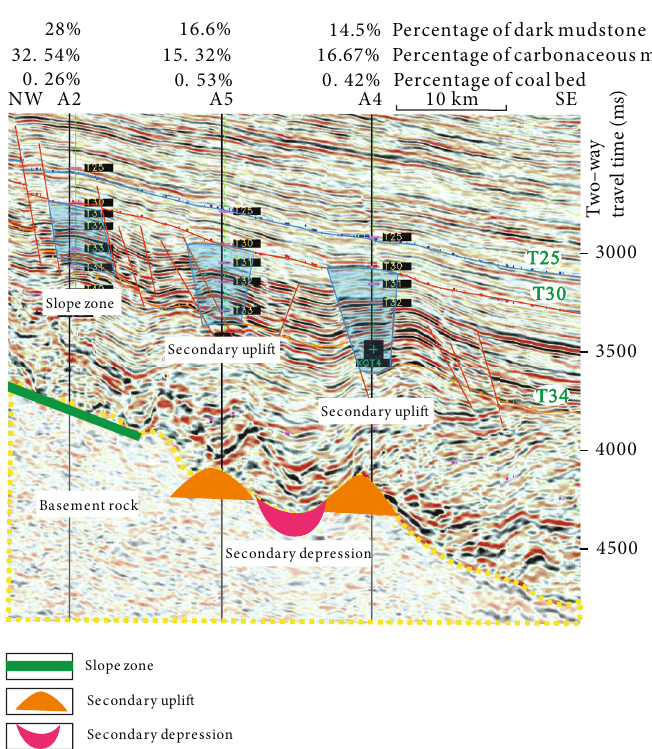
Figure 10: Relationship between terrain and the development of coal-measure source rock in Well Block